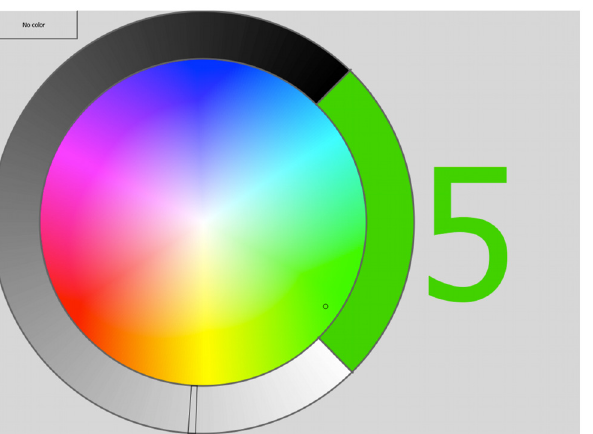
Fig 3. A screen shot from the grapheme-color mapping program used for the screening procedure of the study. Observers adjusted the hue of the right colored area on the annulus by navigating within the color palette. They adjusted the brightness by navigating the bright-to-dark area of the annulus. Navigation was controlled via the mouse pointer or keyboard, dependent on each observer ’ s preference.